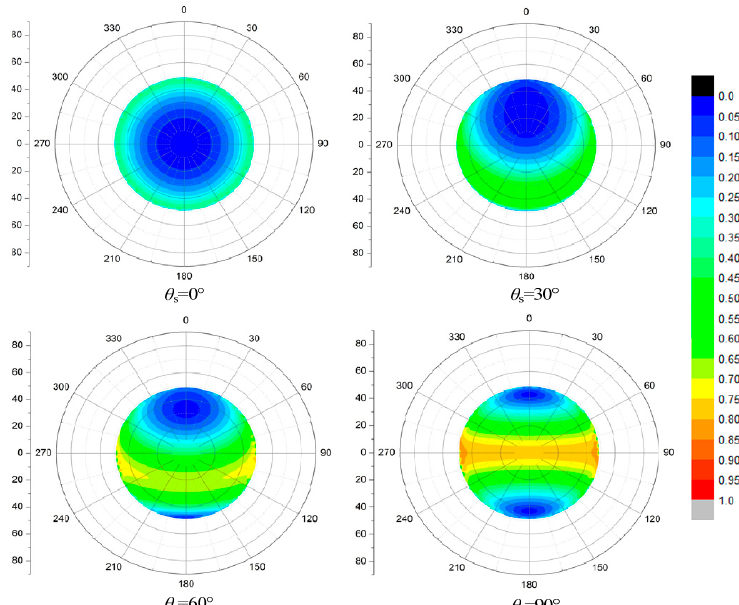
Figure 4. The DOP (degree of polarization) patterns of skylight transmitted through a calm water surface within the Snell’s window at different solar zenith angle θ s = 0°, 30°, 60°, 90°, the DOP ranges from 0 to 1.